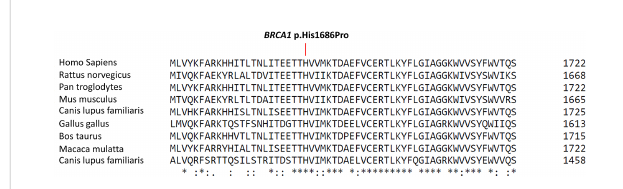
FIGURE 2 Protein sequence alignment of BRCA1 region of interest. The fi gure shows the Cluscal Omega multi-sequence alignment of part of the BRCA1 N-terminal BRCT domain showing the conservation of the THV motif among the species. Location of the BRCA1 p.His1686Pro variant is detailed in the box. An asterisk “ * ” indicates that the amino acid residue is fully conserved among the selected species, a colon “ : ” means that a conservative substitution between residues with similar properties has been observed in the alignment, and a period “ . ” describes a semi-conservative substitution between residues with weakly similar proprieties